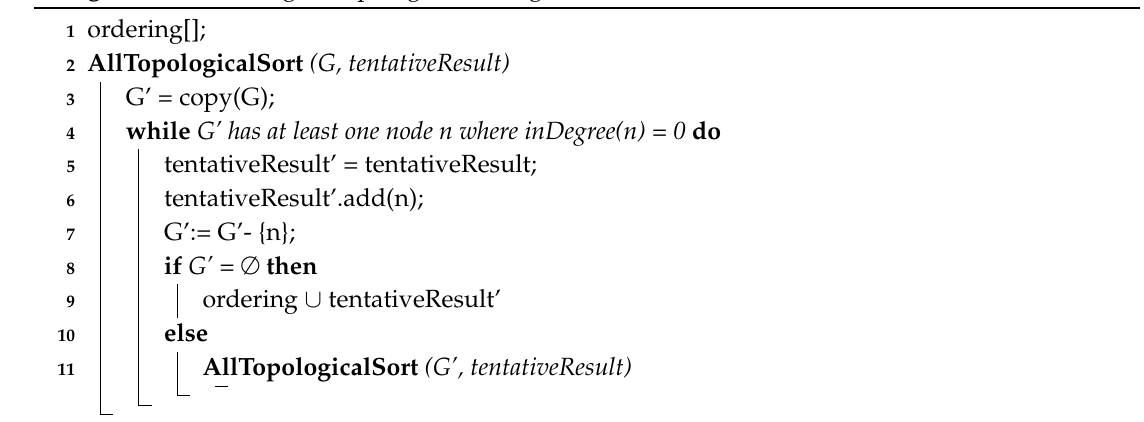
Algorithm 3: Finding all topological